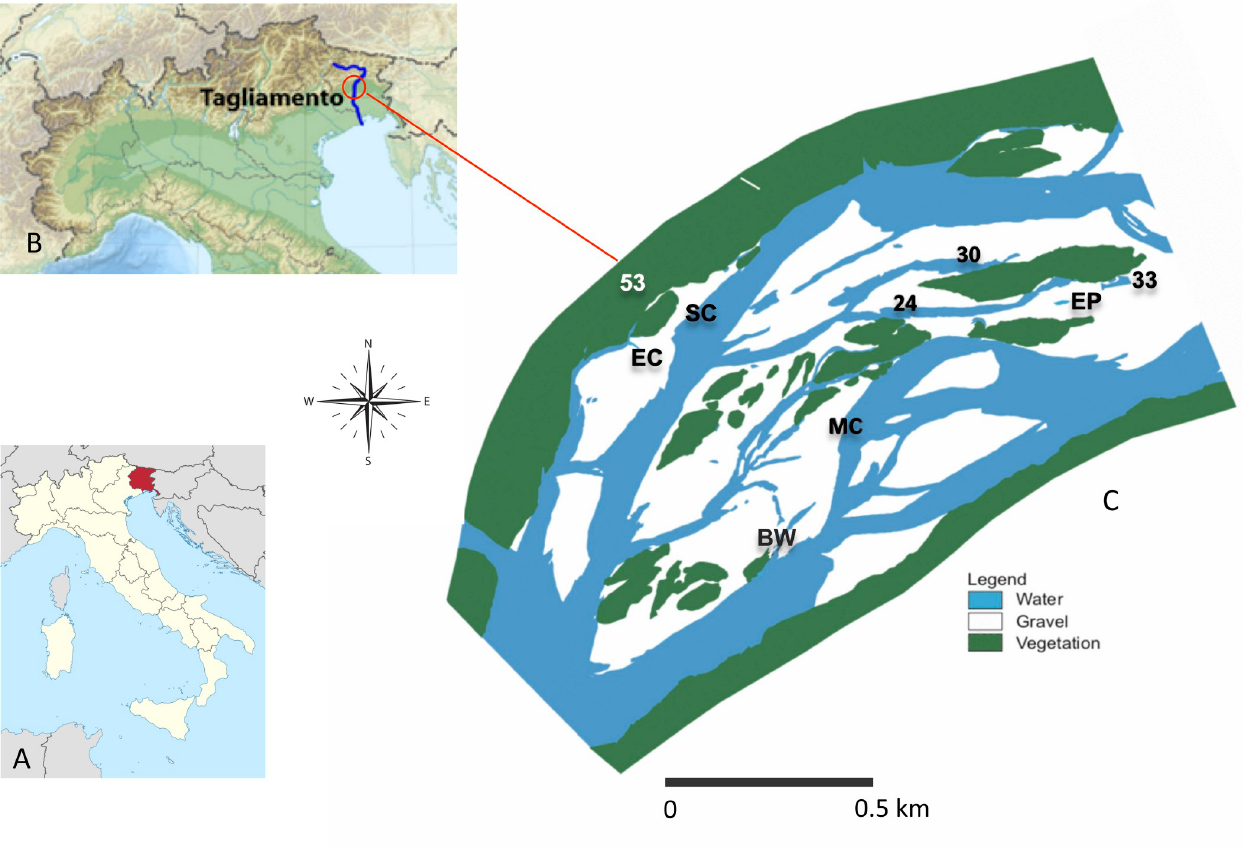
Fig 1. Map of the study area. (A) Map of the Trentino-Alto Adige region. (B) The Tagliamento river. (C) Detailed map of the study floodplain reach and the nine sampling sites (as in September 1999). Description of sites and their connectivity level (in %) is as follows: MC = main channel (100%); SC = side channel (100%); EC = ephemeral channel (25%); BW = backwater (75%); EP = ephemeral pond (0%); 30 = pond (17%); 24 = pond (8%); 33 = pond (0%); 53 = pond (0%).